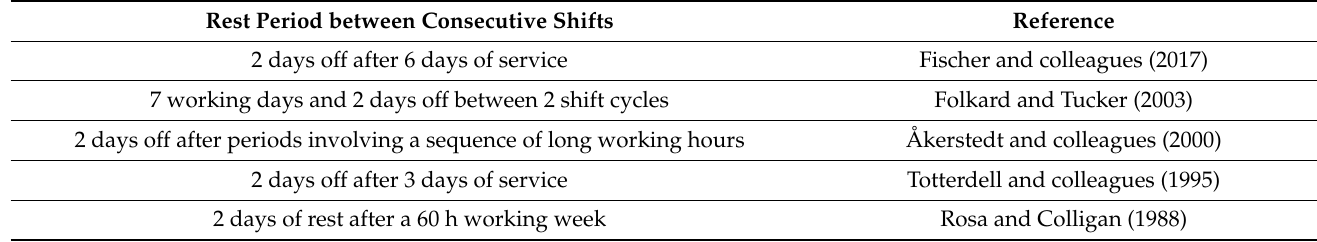
Table 2. Indications on the minimum number of days of rest between consecutive shift cycles.